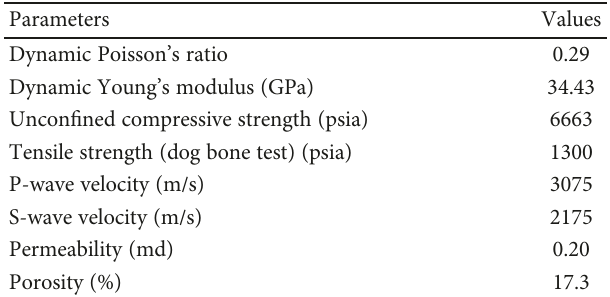
Figure 4: Uncon fi ned compressive strength measurement from the Table 2: Material parameters of the cement sample used in thermochemical and base case fracturing experiments.